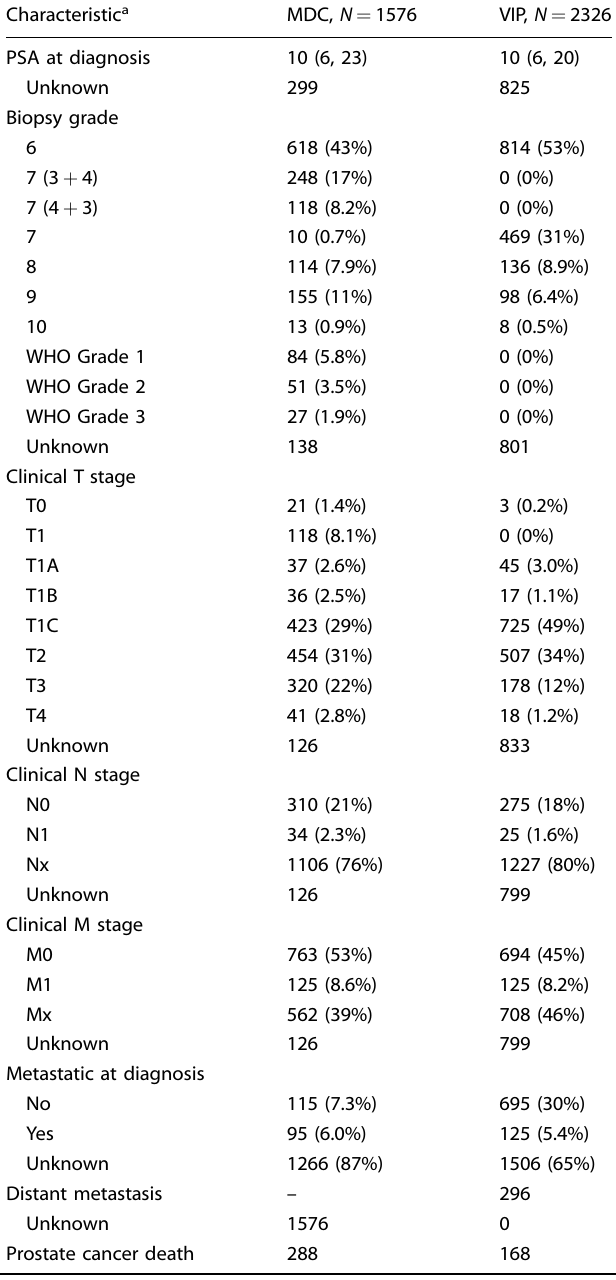
Table 2. Cancer characteristics at diagnosis for incident cases in the full population data for the MDC cohort and the cancer cases from the full nested case-control VIP